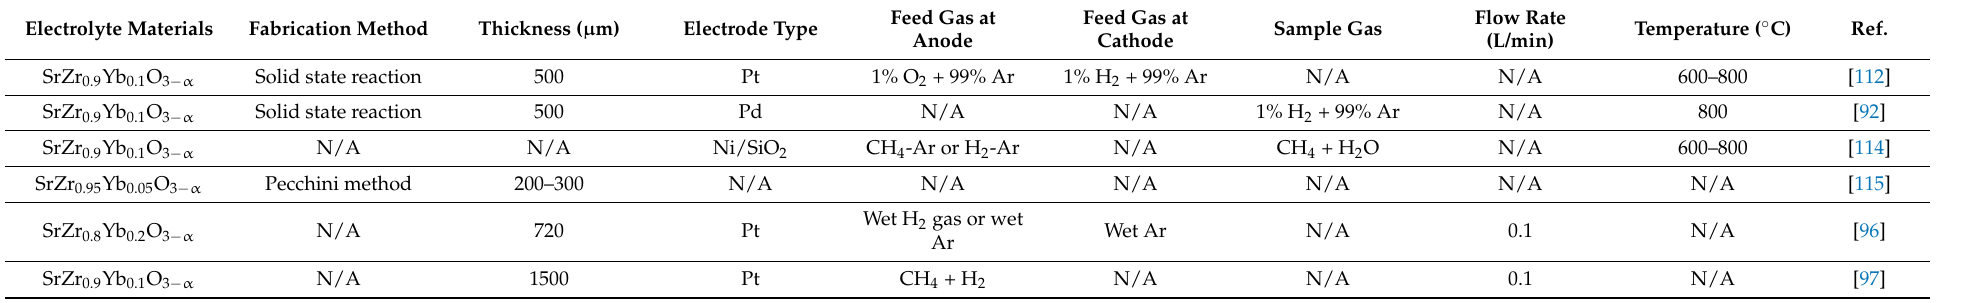
Table 4. Zirconate-based hydrogen pump